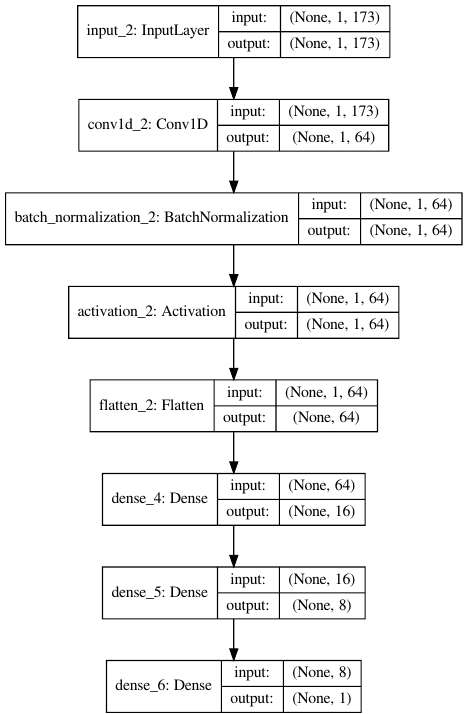
Figure 3. CNN network